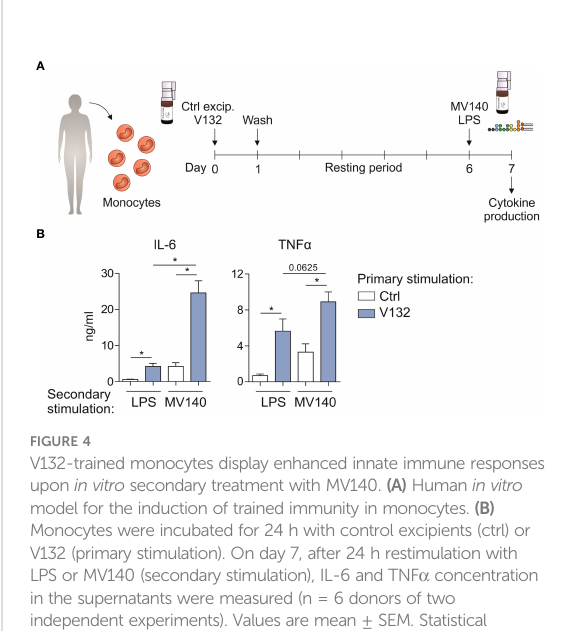
FIGURE 4 V132-trained monocytes display enhanced innate immune responses upon in vitro secondary treatment with MV140. (A) Human in vitro model for the induction of trained immunity in monocytes. (B) Monocytes were incubated for 24 h with control excipients (ctrl) or V132 (primary stimulation). On day 7, after 24 h restimulation with LPS or MV140 (secondary stimulation), IL-6 and TNF a concentration in the supernatants were measured (n = 6 donors of two independent experiments). Values are mean ± SEM. Statistical signi fi cance was determined using Wilcoxon test. *P <